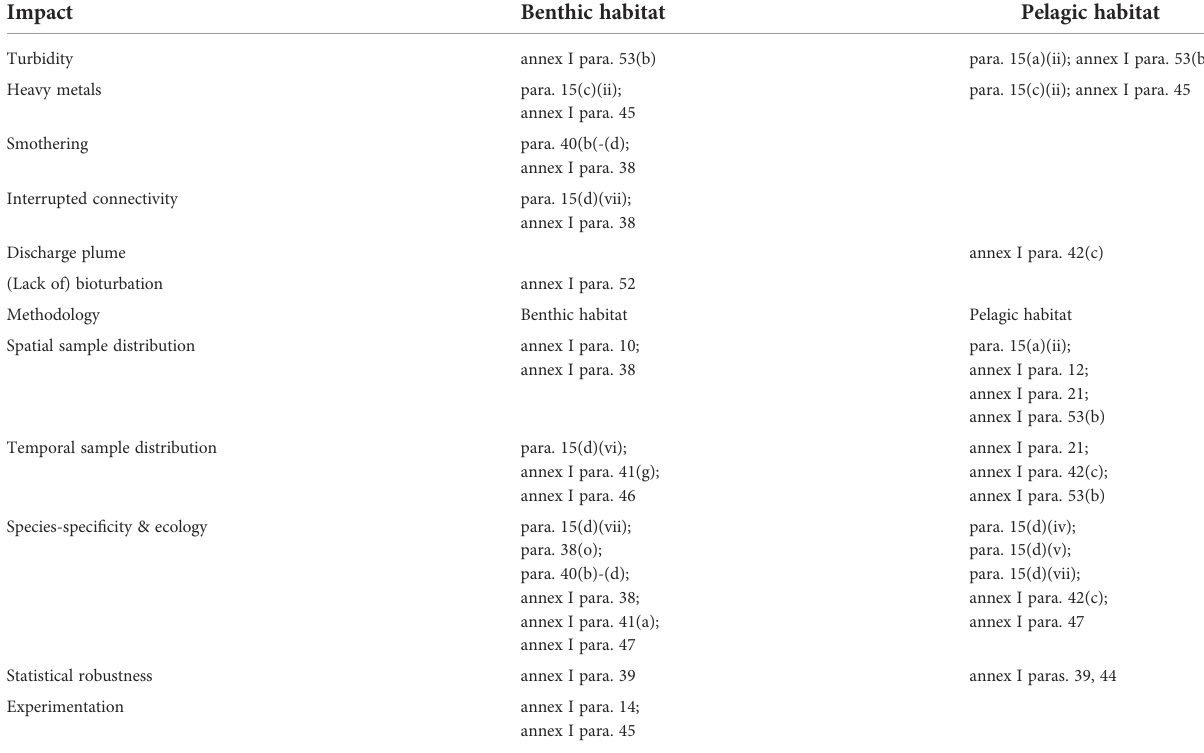
TABLE 2 Selected environmental exploration requirements from ISBA/25/LTC/6/Rev.1 sorted by impact, methodology and habitat. All references are to